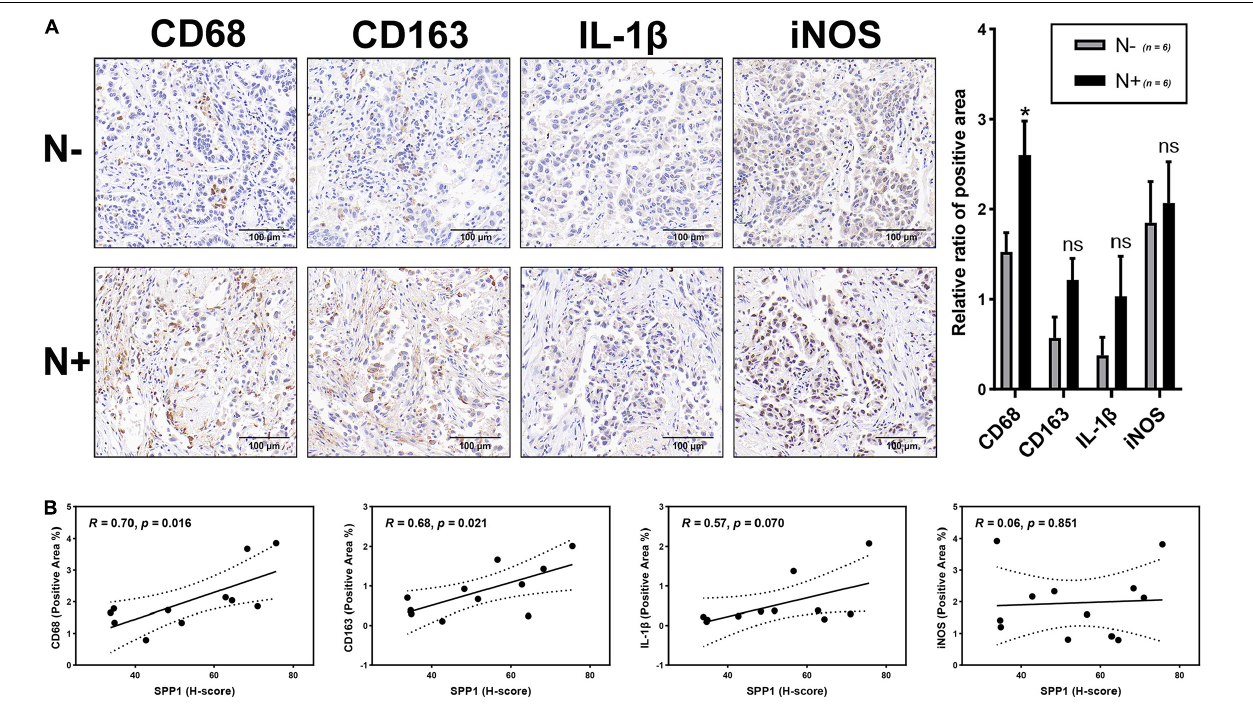
FIGURE 9 | Correlation analysis of macrophages with lymph node metastasis and SPP1 expression. (A) The representative figures of macrophage markers (CD68, CD163, IL-1 β , and iNOS) staining in Stage-T1 LUAD samples and the comparison of positive area ratio in the lymph node metastatic and non-metastatic groups. (B) The H-score of SPP1 was significantly positively correlated with the positive area ratio of CD68 ( R = 0.70, p = 0.016) and CD163 ( R = 0.68, p = 0.021), while the correlation with the positive area ratio of IL-1 β ( R = 0.57, p = 0.070) and iNOS ( R = 0.06, p = 0.851) was not statistically significant.* p <